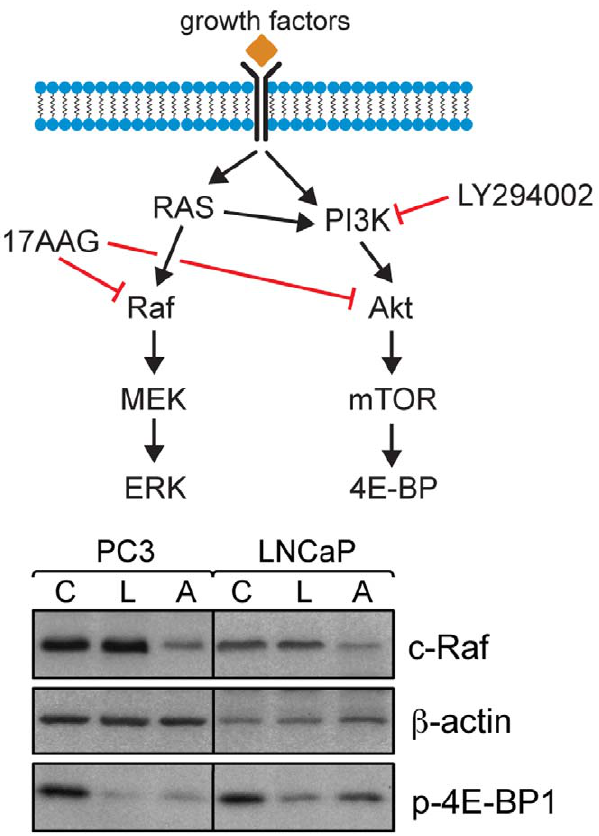
Figure 1. Inhibition of target signaling pathways in cancer cells following drug treatment. Schematic of signaling pathways targeted by LY294002 and 17AAG and Western blots showing modulation of p-4E-BP1 and c-Raf ( b -actin as loading control) levels following administration of DMSO (solvent control; C), LY294002 (L) or 17AAG